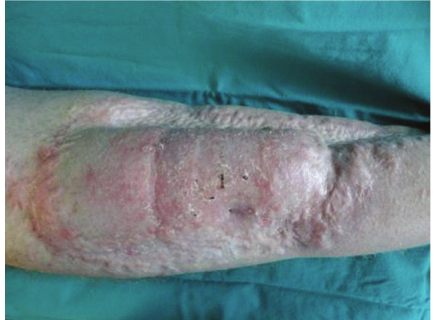
Figure 2: Pedicle resection after 1 month; a meshed split-thickness skin graft was used to cover remaining wound.